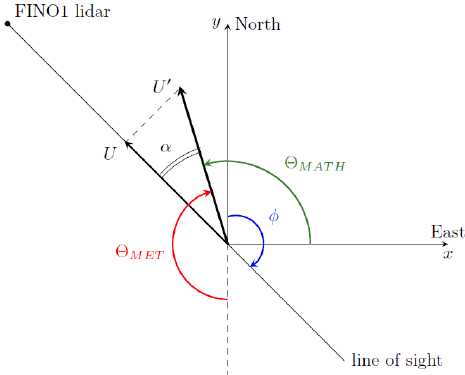
Figure 11. The relation between radial wind speed U , actual wind speed U (cid:48) , azimuth angle φ , and meteorological and mathematical wind directions (cid:50) MET and (cid:50) MATH